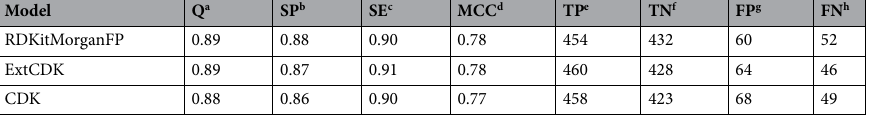
Table 6. Evaluation of RF models trained with circular fingerprints to predict the UV–Vis absorption spectrum of organic molecules in test set II. a Overall predictive accuracy. b Specificity. c Sensitivity. d MCC, Matthews correlation coefficient. e True Positives. f True Negatives. g False Positives. h False Negatives.